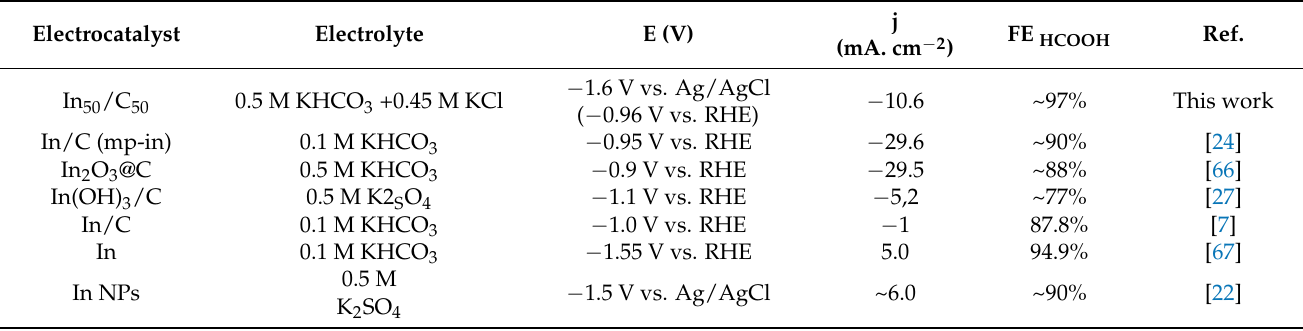
Table 2. Performance of In-based catalyst in the CO 2